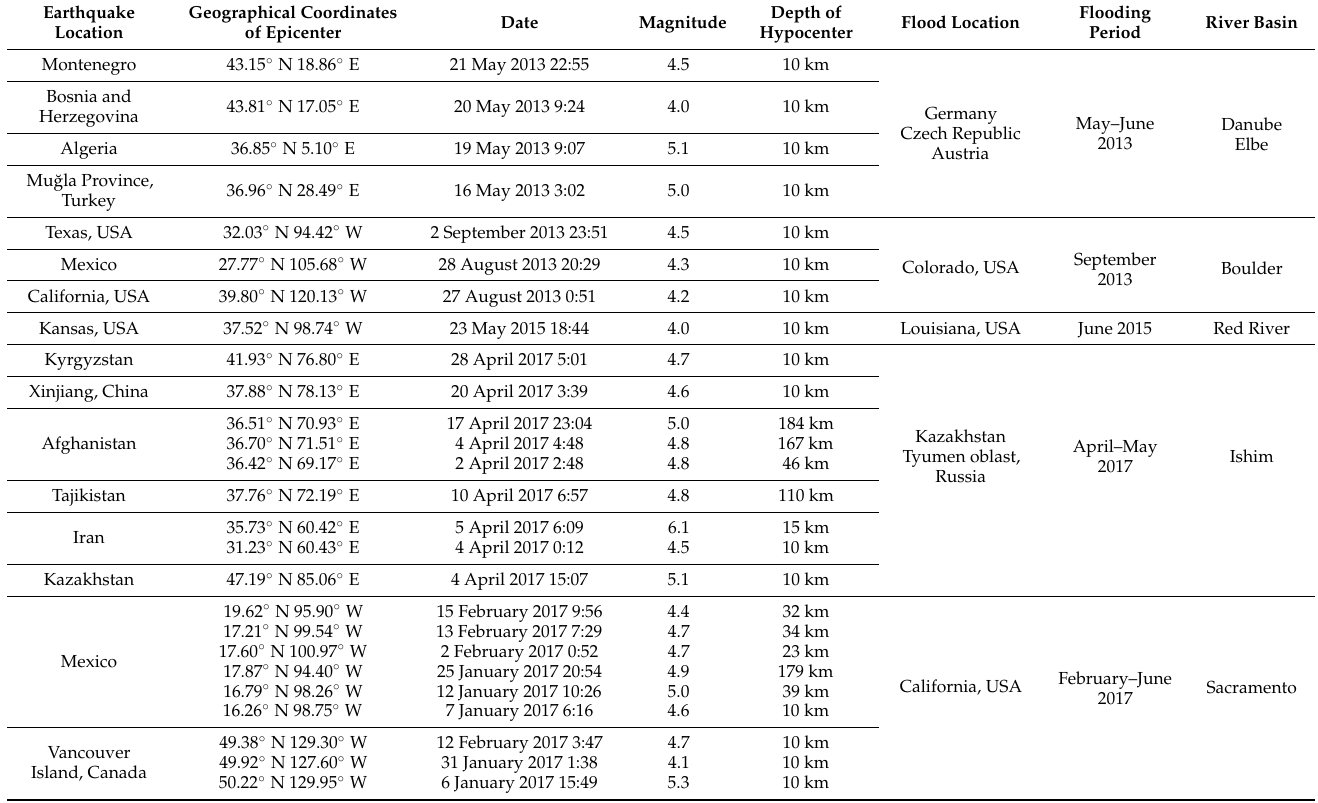
Table 1. Data on several earthquakes and